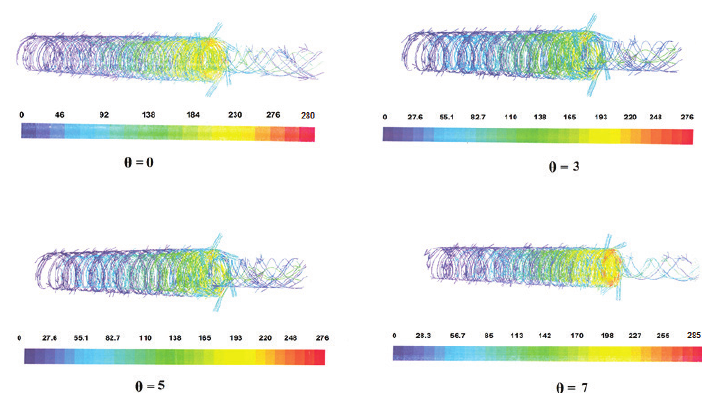
Figure 16. The contours of the velocity magnitude for axial angle inlet nozzles of θ = 0°, 3°, 5° and 7°